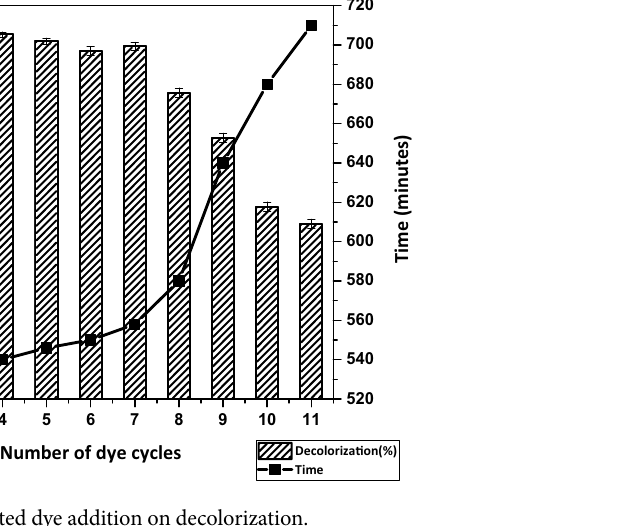
Figure 2. Effect of repeated dye addition on